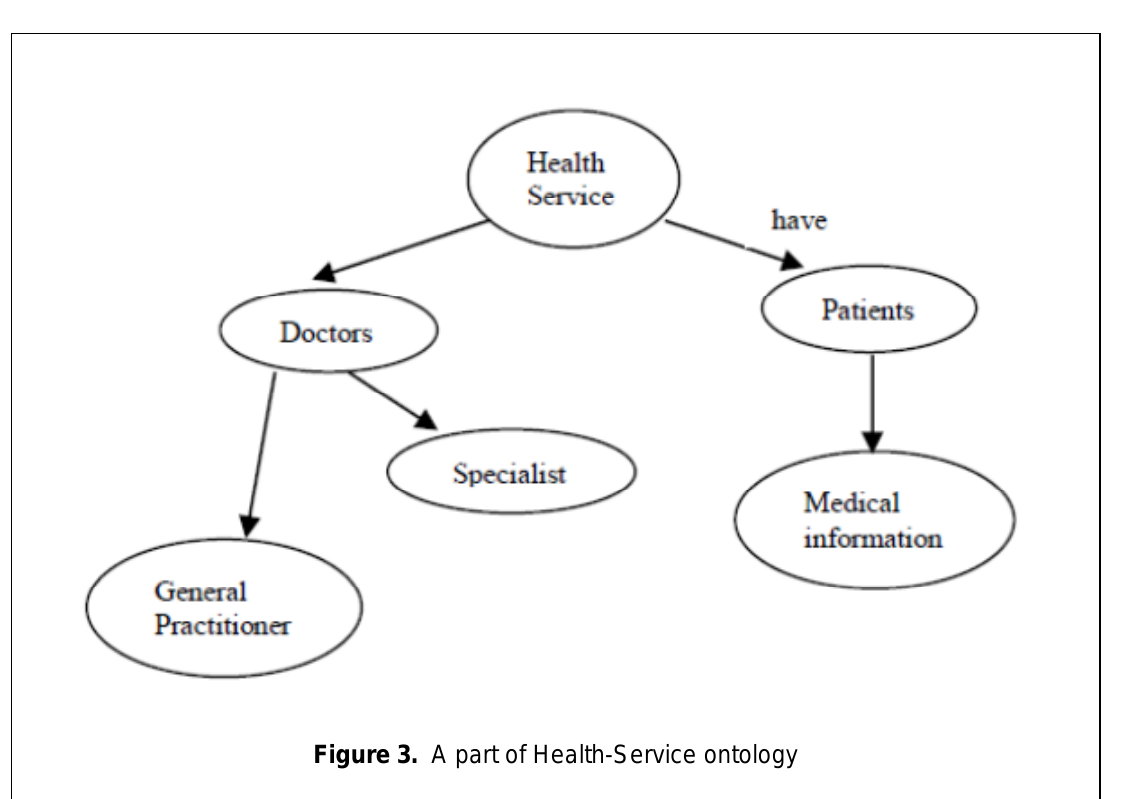
Figure 3. A part of Health-Service